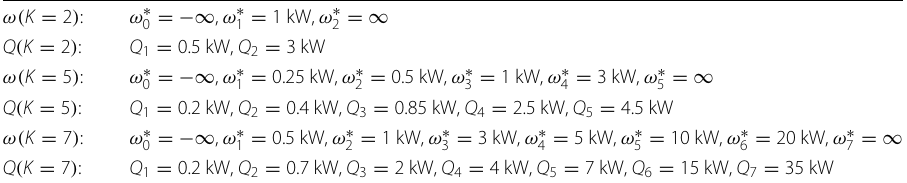
Table 2 Quantization boundaries and quantized